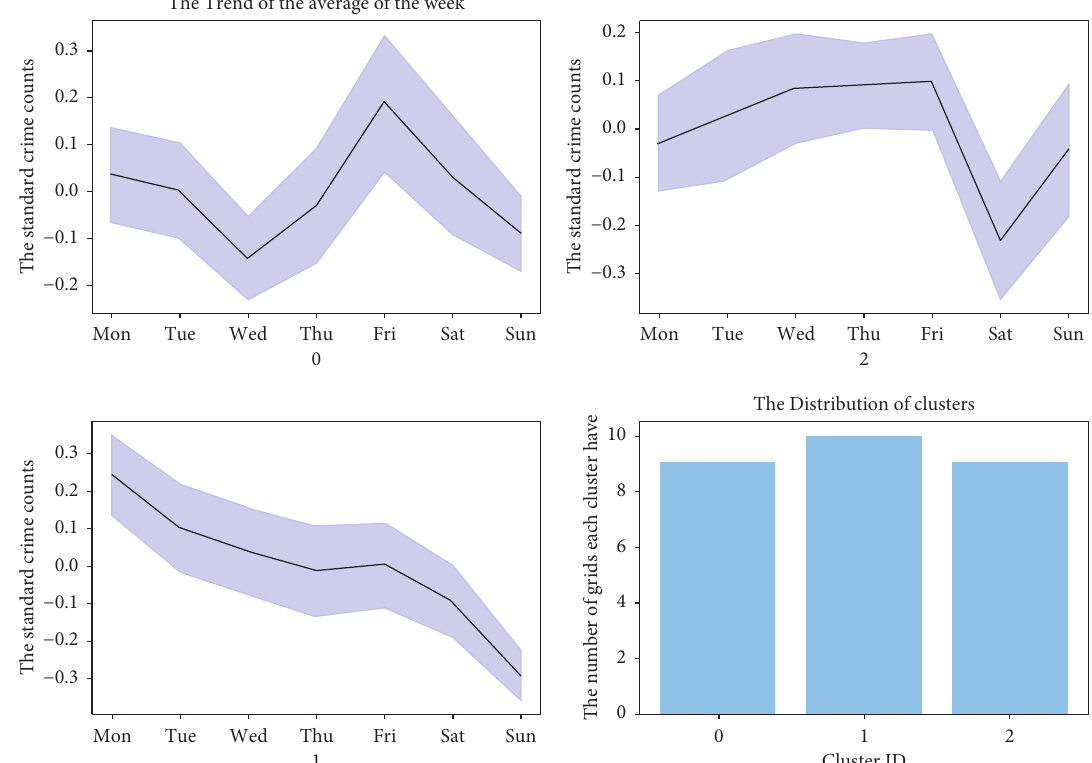
Figure 2: Chicago 2018 burglary weekly trends and distributions of the clusters. The line charts are the weekly trends of burglary in Chicago in 2018. The bar chart is the distribution of the